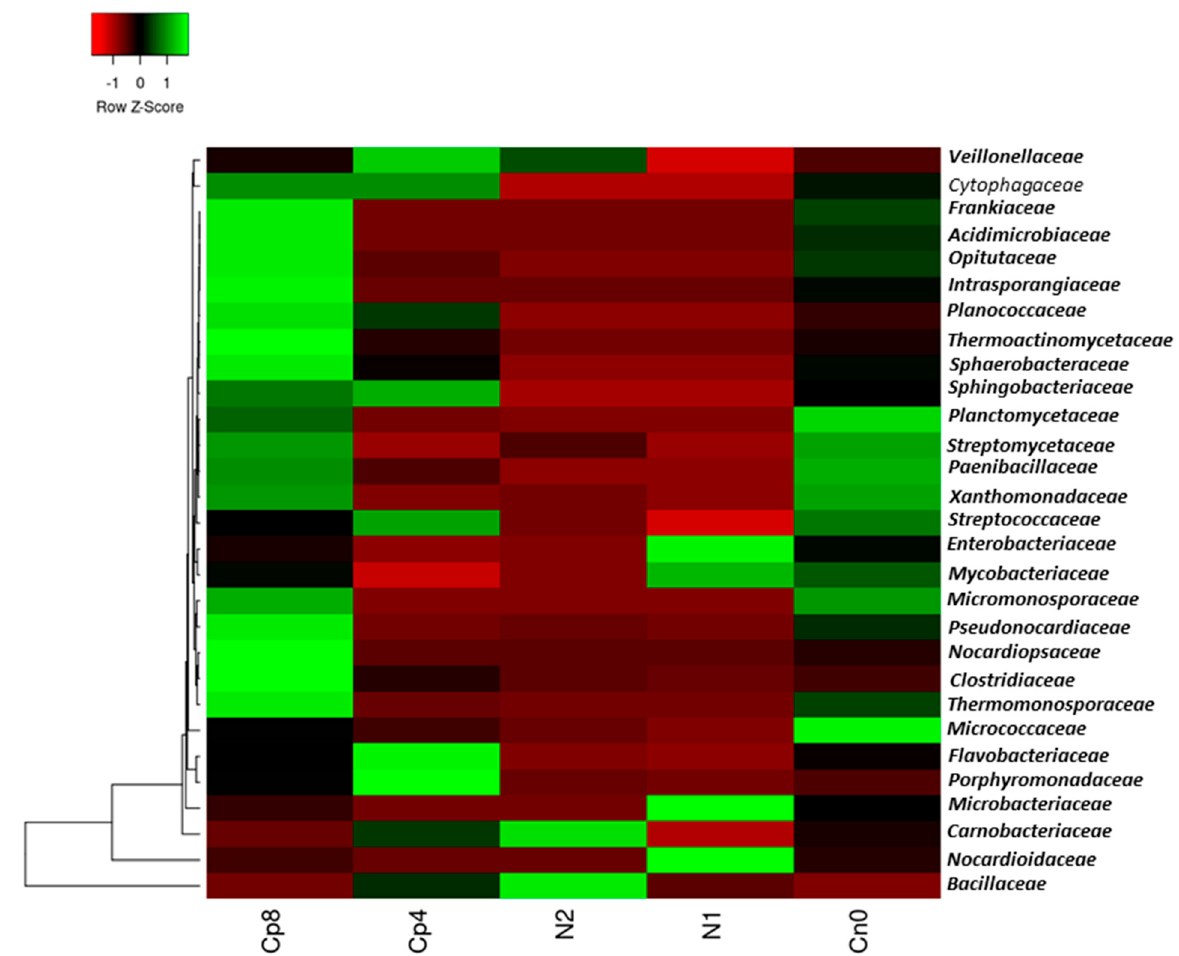
Figure 1. Relative abundance of dominant bacteria families in the maize rhizosphere samples under fertilization and unfertilized soil treatments. Cp8 (8 tons/ha compost manure), Cp4 (4 tons/ha compost manure), N2 (120 kg/ha inorganic fertilizer), N1 (60 kg/ha inorganic fertilizer), and Cn0 (control). The Z-score shows the level of abundance of the bacteria in the various soil samples. The green color represents the most abundant bacterial family, while the red color depicts less abundance within the samples.